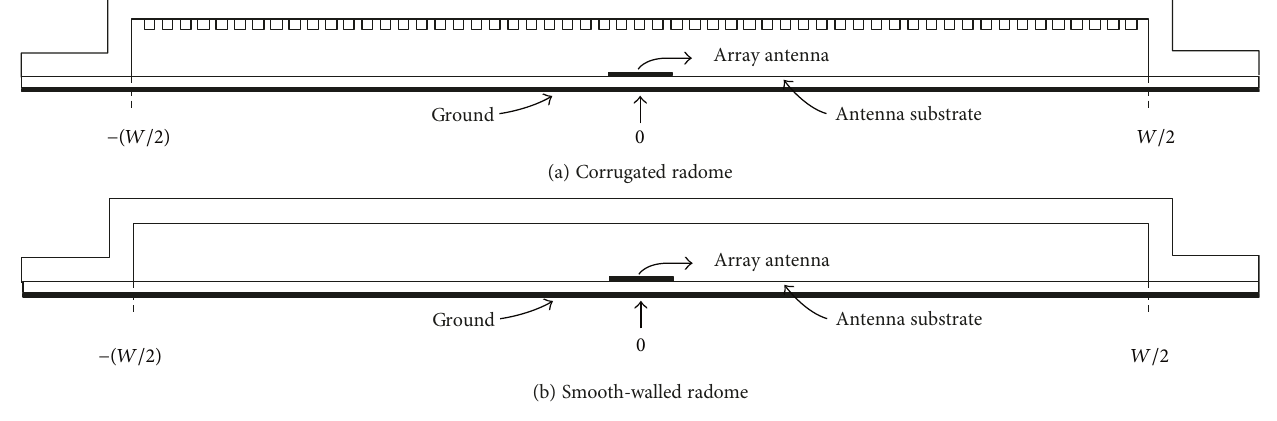
Figure 4: Simulation model for extracting near- fi eld region e- fi eld distribution. Table 1: 3dBi beam widths of the di ff erent radome